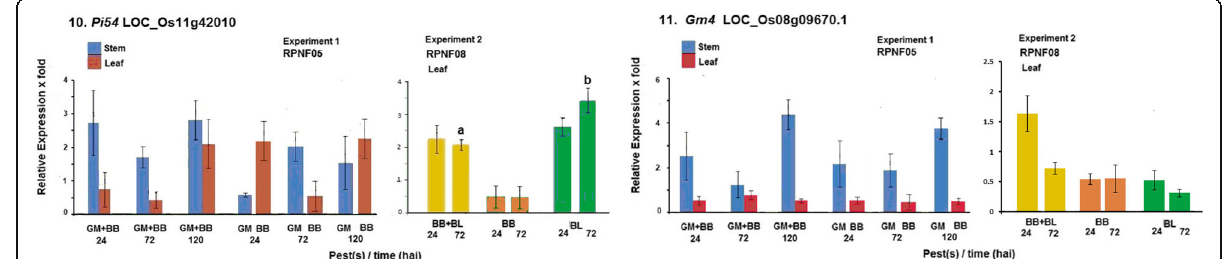
Fig. 4 Relative levels of expression of Pi54 and Gm4 in rice line RPNF05 following challenge by BB and/or GM (Experiment 1) or in RPNF08 following BB and/or BL infection (Experiment 2). Column means ± SE with different letter are significantly different (paired t test, P < 0.05)